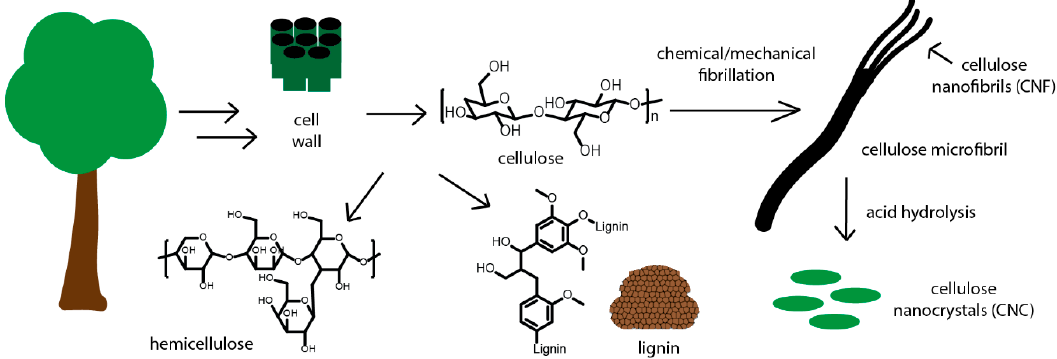
Figure 2. Plant cell walls comprised of cellulose, lignin, and hemicellulose. The cellulose can be further isolated and broken down into microfibrils, CNFs, and CNCs.